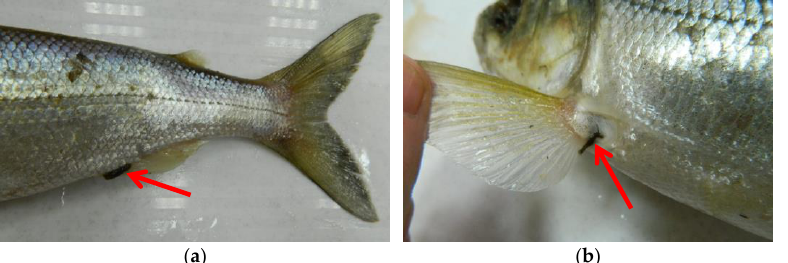
Figure 3. Location of leech ectoparasites on Baikal omul caught in the Selenga River: ( a ) at the abdominal fin and ( b ) at thoracic fin.